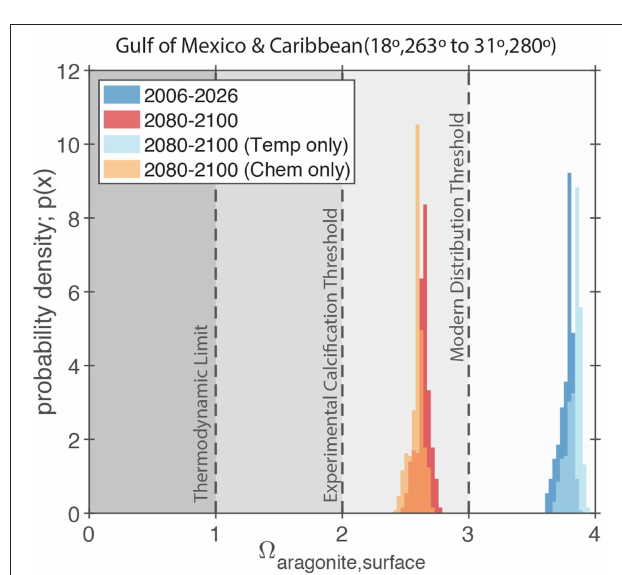
FIGURE 10 | Simulated values of (cid:127) aragonite for the GoM and northern Caribbean Region (i.e., the region shown in Figure 7A ) in the RCP8.5 Large Ensemble, CESM1.2. The dark blue and dark red probability density functions (PDFs) show the model predictions for the 2006–2026 and 2080–2100 periods, respectively. The light blue and orange PDFs show the model predictions for the 2080–2100 period where either ocean chemistry or water temperature is held constant at the 2006–2026 values. The gray shading and dashed lines indicate the typical limits for the presence of scleractinian corals in the modern ocean ( (cid:127) > 3; Kleypas et al., 1999), the experimentally measured limits for calcification by coral reef communities ( (cid:127) > 2; Langdon et al., 2000; Albright et al., 2008), and the thermodynamic limit for aragonite precipitation ( (cid:127) =